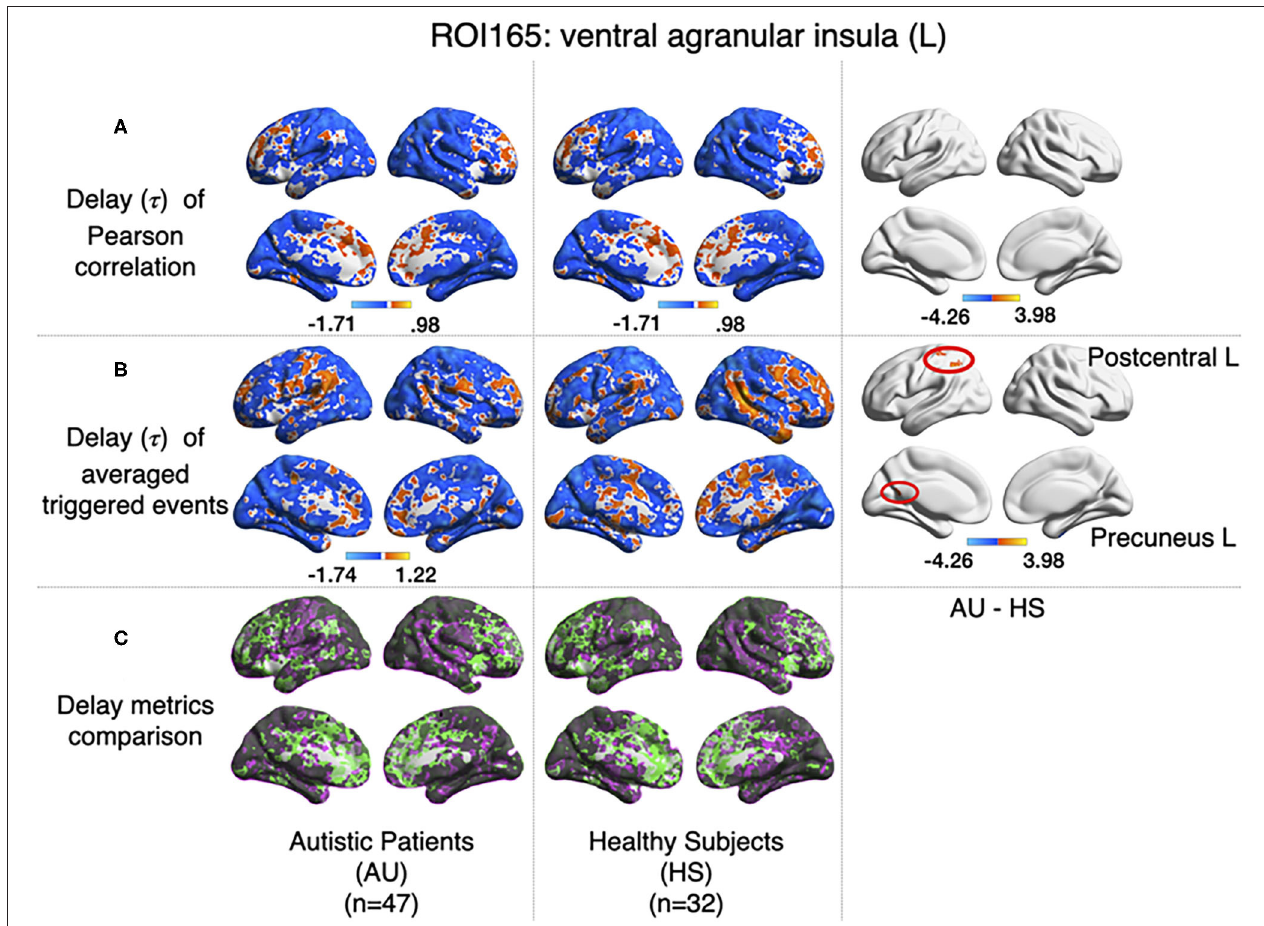
FIGURE 7 | Comparison of the delays values estimated with the Pearson (A) and the event correlation (B) for AU and HS. Left columns show the average delays for AU, middle columns the average delays for HS, and the right column the comparison between groups (AU minus HS). The two circles (postcentral gyrus) indicate significant differences not evident with standard methods (GFR corrected voxel p < 0.001, cluster p < 0.05). (C) Compares (A,B) , where gray areas show coincidences between metrics; pink shows areas where B > A, and green shows A >